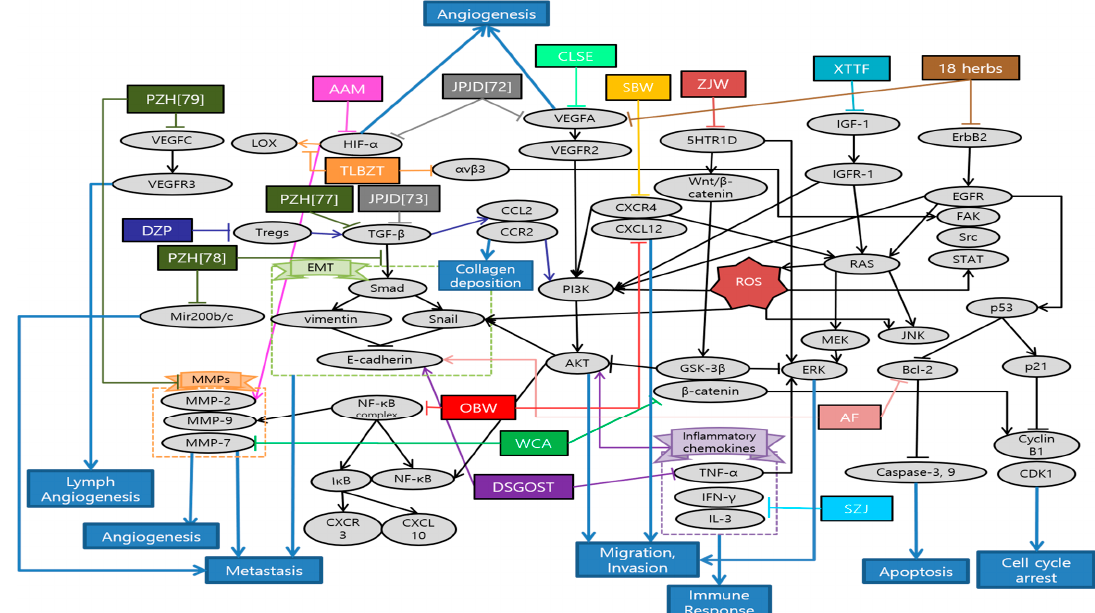
Figure 2. Schematic diagram of anti-metastatic mechanisms of herbal medicine in colorectal cancer: Herbal medicines suppress angiogenesis, migration and invasion via inactivation of diverse HIF-1 α pathways. Tumor hypoxia results from the imbalance between the oxygen supply and demand due to the uncontrolled tumor cell proliferation. Under hypoxic condition, HIF-1 α expression is accumulated as a pro-angiogenic factor, which is mainly involved in MMP-2 production. Hypoxia also activates the phosphorylation of ERK1/2 and AKT, which make cancer cell migration and invasion possible. Over-activation of mTOR, the key regulator of cancer progression, is frequently associated with activation of HIF-1 α , which stimulates tumor genesis, angiogenesis, and tumor growth through VEGF. Furthermore, herbal medicine suppress metastasis by impeding EMT-related cascades. EMT refers to the development of mesenchymal cells through a series of changes in epithelial cells, playing an important role in the cancer cells growth via regulation of immunosuppressive tumor microenvironment. TGF- β activates the Smad pathway, which leads to other EMT-related protein expressions. In the same way, TGF- β 1 modulates ZEB leading to EMT and miR-200 expression. TNF- α also induces nuclear translocation of Snail via AKT/GSK-3 β pathway. Meanwhile, herbal medicine can serve similarly with antagonists of 5-HTR1D suppressing Wnt/ β -catenin signal transduction via β -catenin degradation. 5-HTR1D influences the Wnt/ β -catenin signaling at the upper stream, leading to stabilization of β -catenin in cells. MMP-7 is transcribed in response to Wnt- β -catenin signaling which assists the degradation of extra-cellular matrix (ECM), a critical event in tumor invasion and metastasis. In terms of immune regulation, herbal medicine can enhance certain plasma cytokines such as GM-CSF, increasing the number of macrophages in the spleen which contribute to the immune response and the prolongation of survival time. Abbreviation: AF, Arctii Fructus extract; SBW, Scutellaria barbata water extract; CLSE, Coix lacryma-jobi var. ma-yuen Stapf sprout extract; AAM, Astragalus Atractylodes mixture; DZP, Dahuang Zhechong Pill; DSGOST, Danggui-Sayuk-Ga-Osuyu- Senggang-Tang; 18 herbs, Formula of the aqueous extracts of 18 herbs; JPJD, Janpi Jiedu; SJZ, Modified Si-Jun-Zi Decoction; OBW, Onbaekwon; PZH, Pien Tze Huang; TLBZT, Teng-Long-Bu-Zhong-Tang; WCA, Weichang’an; XTTF, Xiaotan Tongfu; ZJW, Zuo Jin